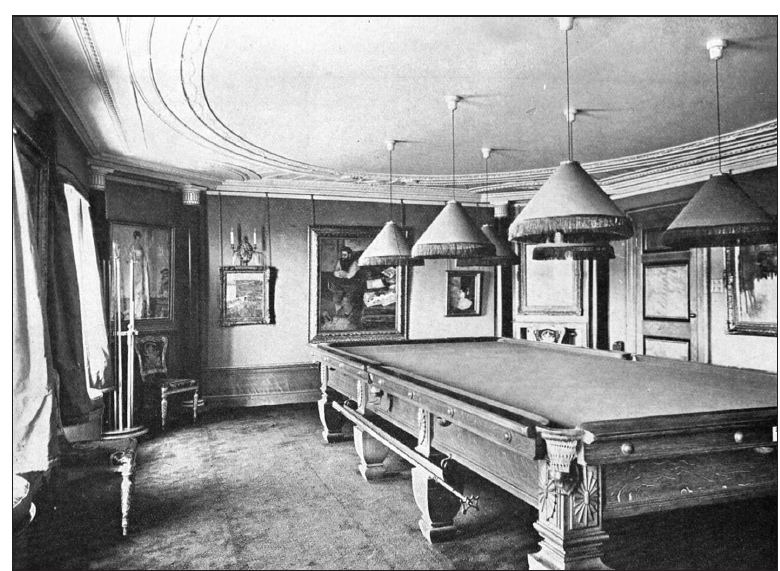
Fig. 5 : The Billiard Room, 3 Seamore Place, Park Lane, ‘Interior Domestic Architecture’, Academy Architecture and Architectural Review , 53 (1921), p. 39. National Library of